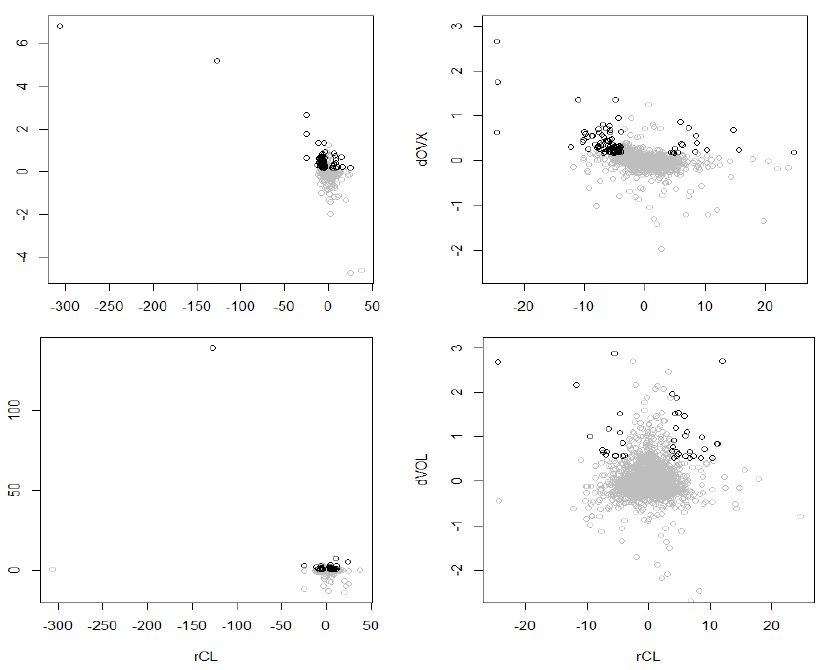
Figure 2. Common exceedances of extreme values. The left panel shows all data, the right panel data without outliers. Note: Extreme values mean exceedances of the 5th and 95th quantiles of Crude Oil Future Contract returns (rCL) and the 95th quantile of changes in the CBOE Crude Oil Volatility Index (dOVX), and in volatility (dVOL).